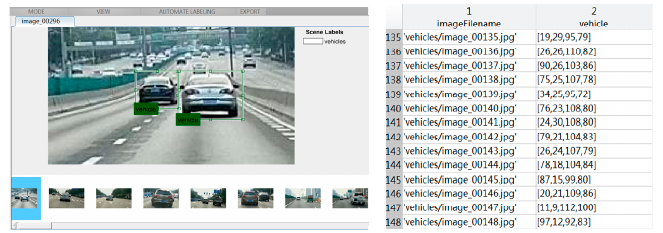
Figure 3. Production of vehicle data sets.